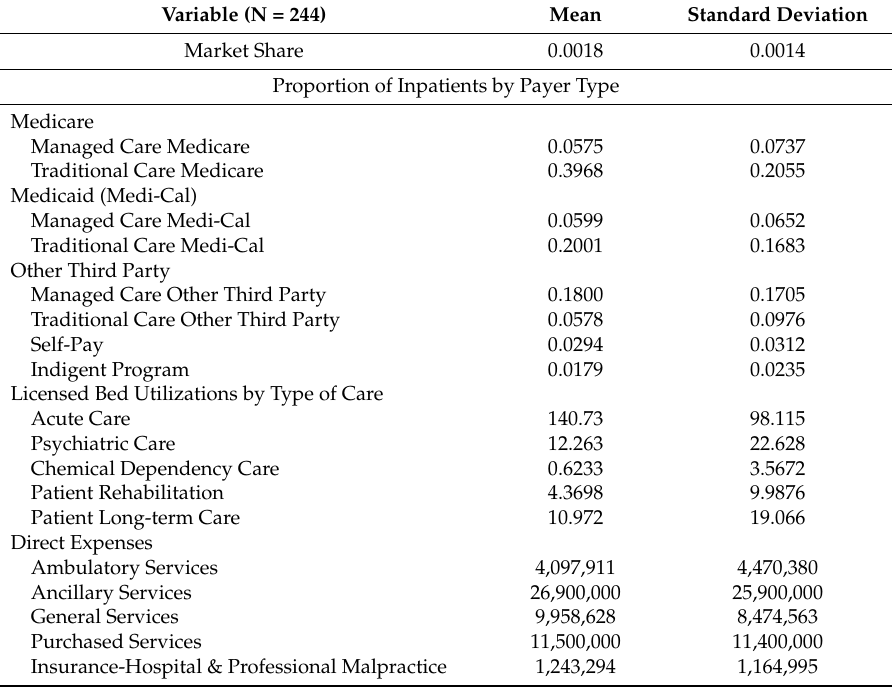
Table 8. Variables, Means, and Standard